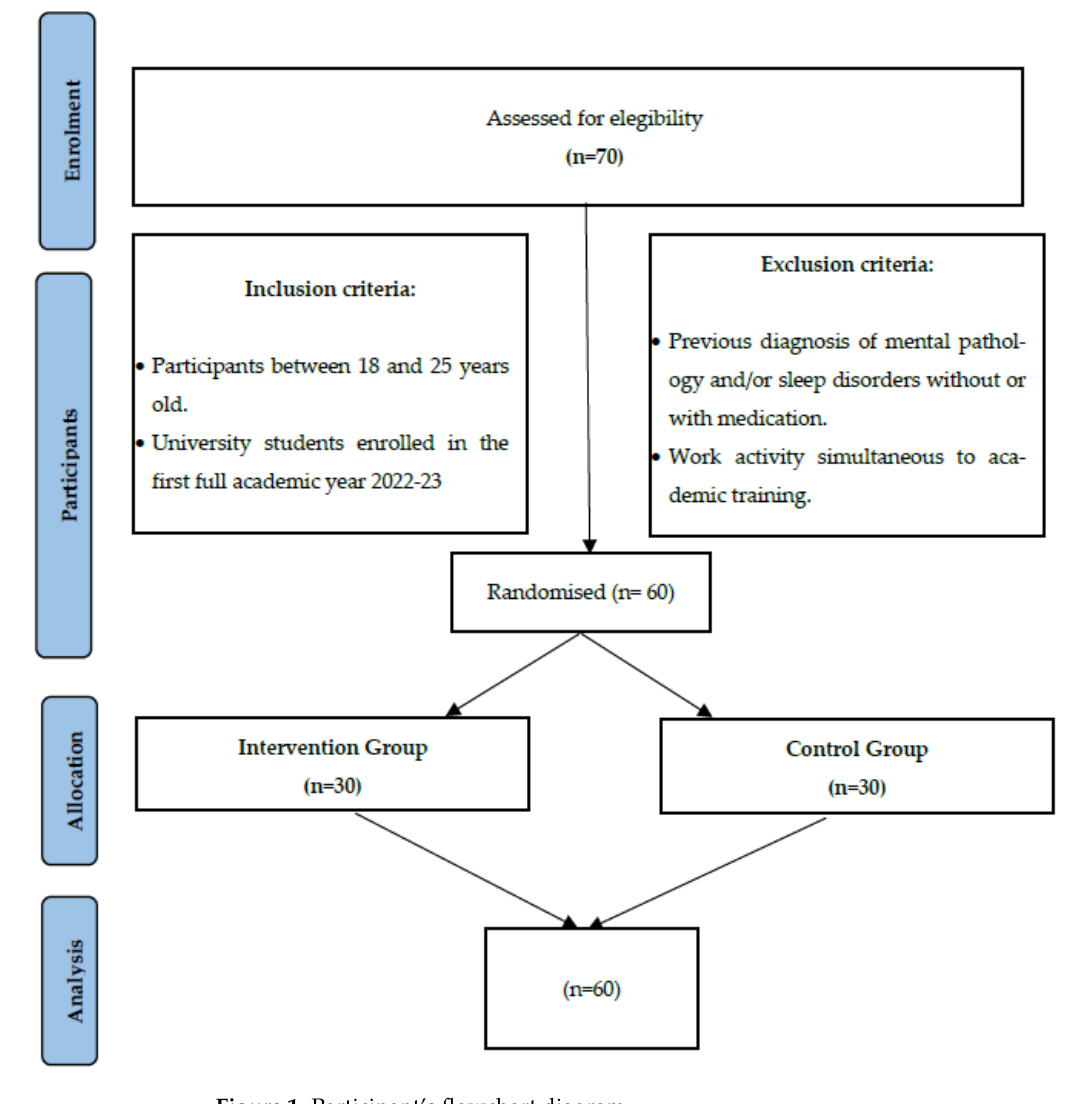
Figure 1. Participant’s flowchart diagram.